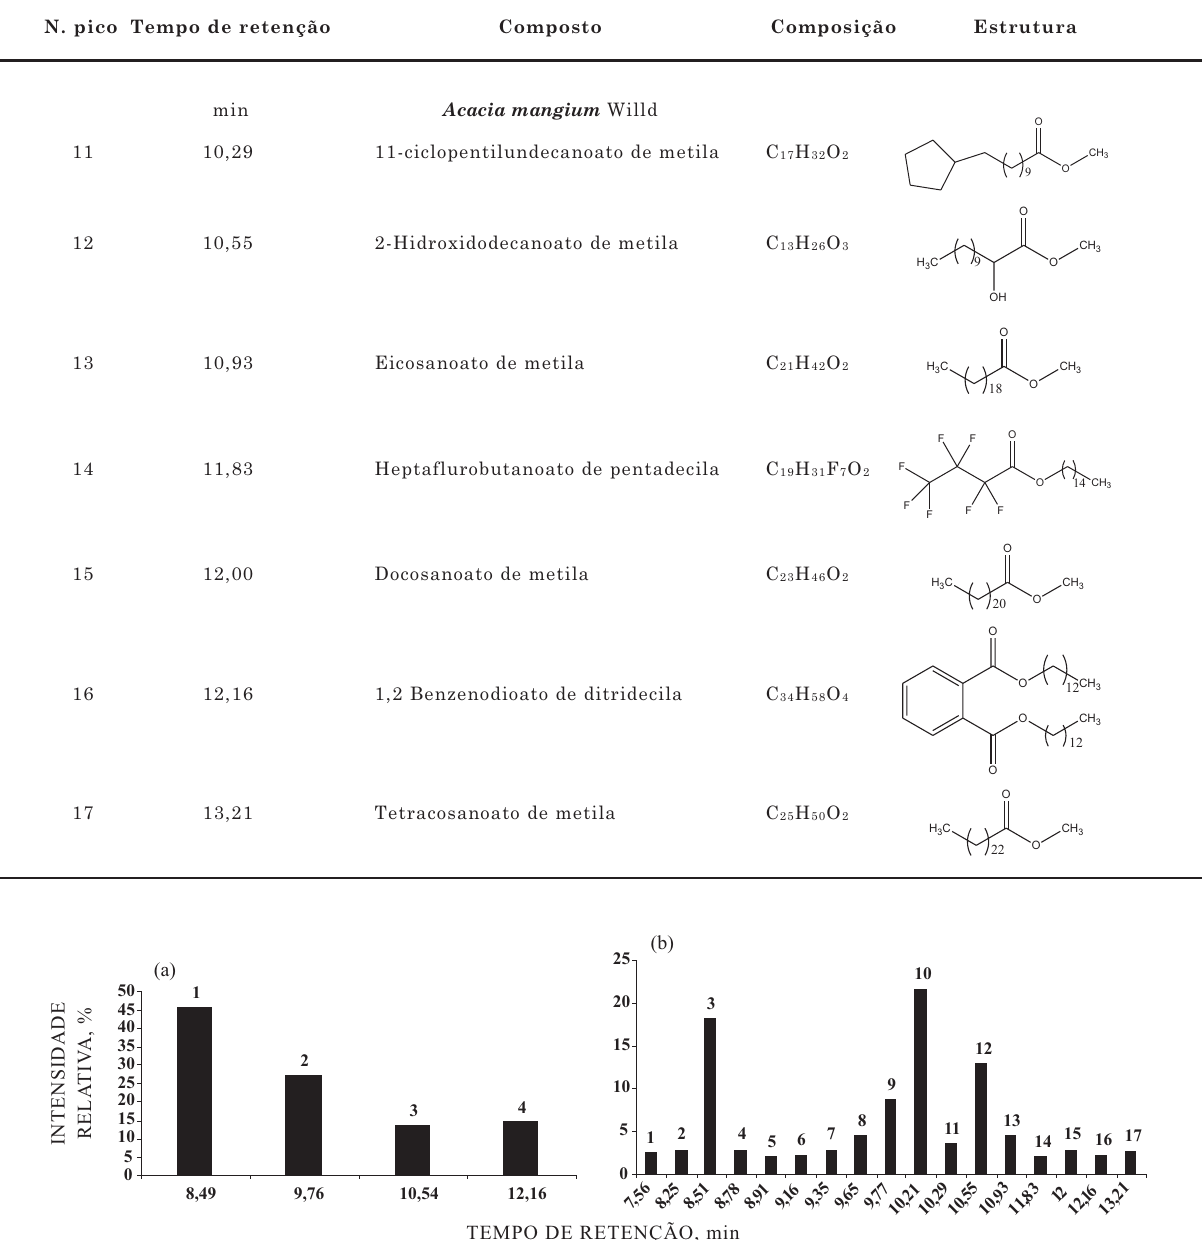
Figura 4. Percentagem relativa dos compostos orgânicos da subfração alifática presentes na humina extraída de amostras de solo degradado pela extração de argila, com vegetação espontânea [ Brachiaria mutica (Forsk.) Stapf] (A) e em área com Acacia mangium Willd (B). Os números nas barras dos gráficos referem-se aos picos correspondentes dos